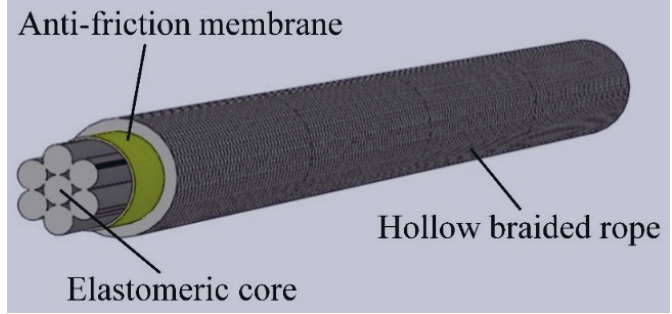
Figure 1. Representation of the Exeter Tether